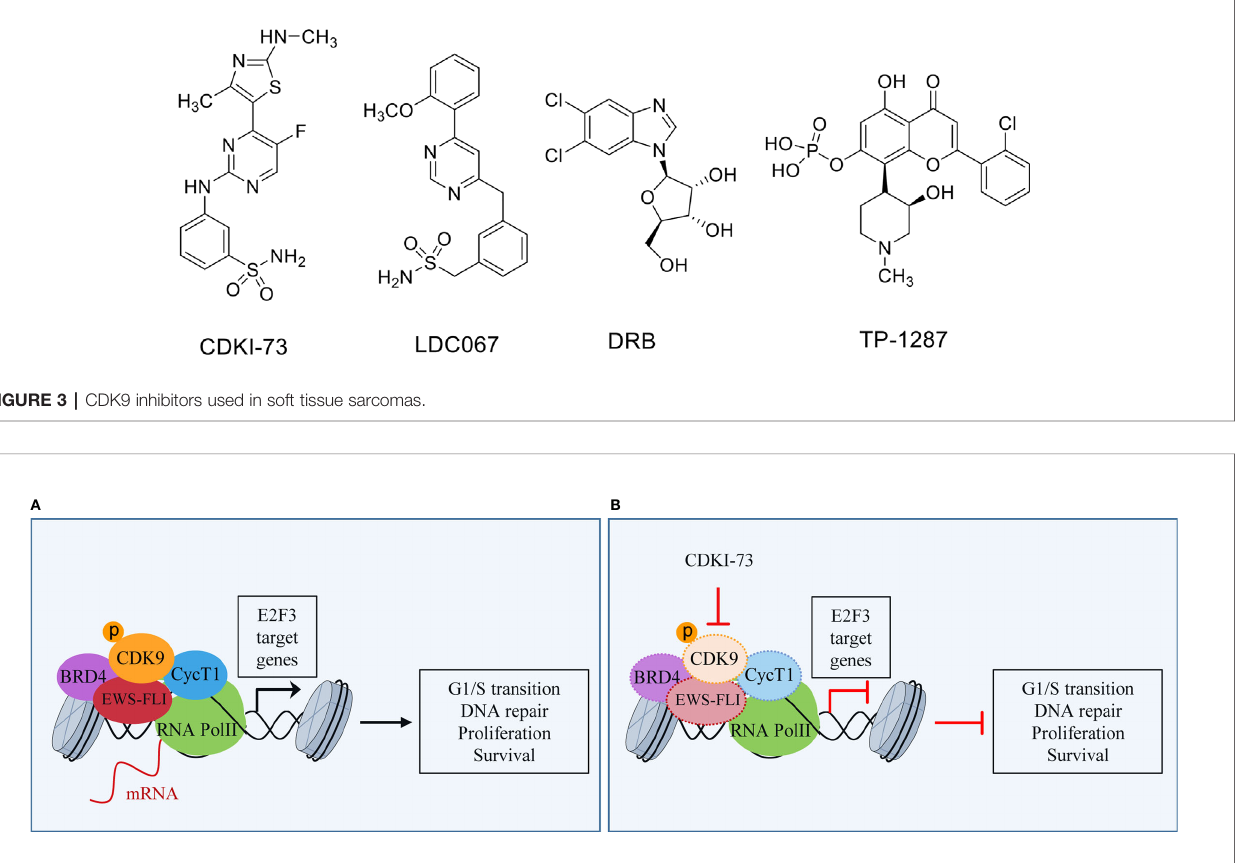
FIGURE 4 | CDK9 function in Ewing ’ s sarcoma (ES): (A) activated p-CDK9/CycT1 complex (known as P-TEFb) binds to bromodomain protein 4 (BRD4) and the fusion protein EWS-FLI to induce the transcription of E2F3 target genes and promotes G1/S cell cycle transition, DNA repair, proliferation, and cancer cell survival. (B) CDK9 inhibitor CDKI-73 reduces the expression of CDK9, EWS-FLI, CycT1, and partly that of BRD4, thus inhibiting E2F3 transcriptional program and the tumorigenic